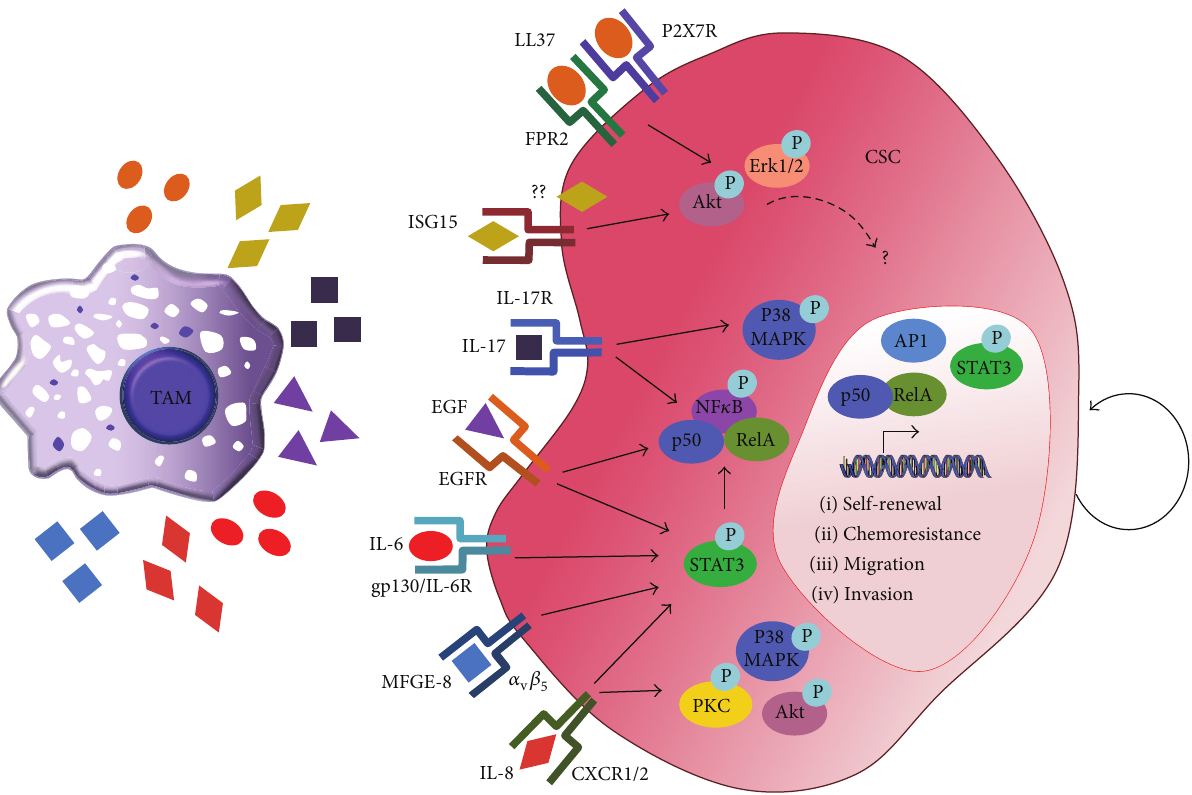
Figure 4: TAM-secreted factors regulate CSC phenotypes. TAMs have been shown to secrete LL-37, ISG15, IL-17, EGF, IL-6, MFGE-8, and IL-8 (among others), which in turn activate MAPK, STAT3/NF 𝜅 B, and other yet-to-be-defined signaling pathways, leading to the activation of CSC properties, such as self-renewal, chemoresistance, migration, and